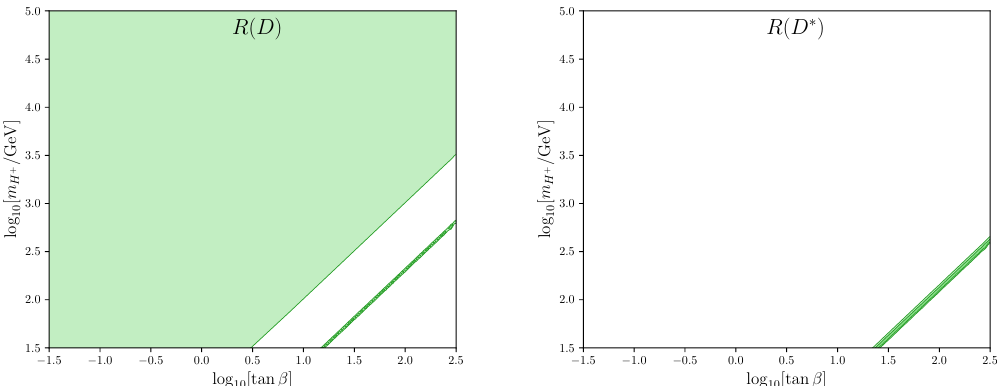
Figure 5. Contour plot of the allowed 2HDM-II parameter space in the (tan β − m originating from R ( D ) (left) and R ( D ∗ ) (right). The lighter contour indicates the allowed parameter space at 2 σ confidence level while the darker contour corresponds to 1 σ